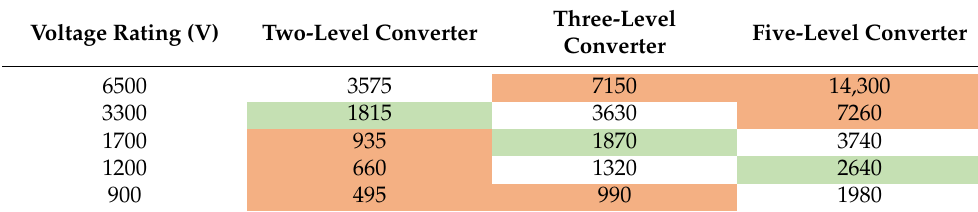
Table 9. Suitable DC link voltages including de-rating (Source: